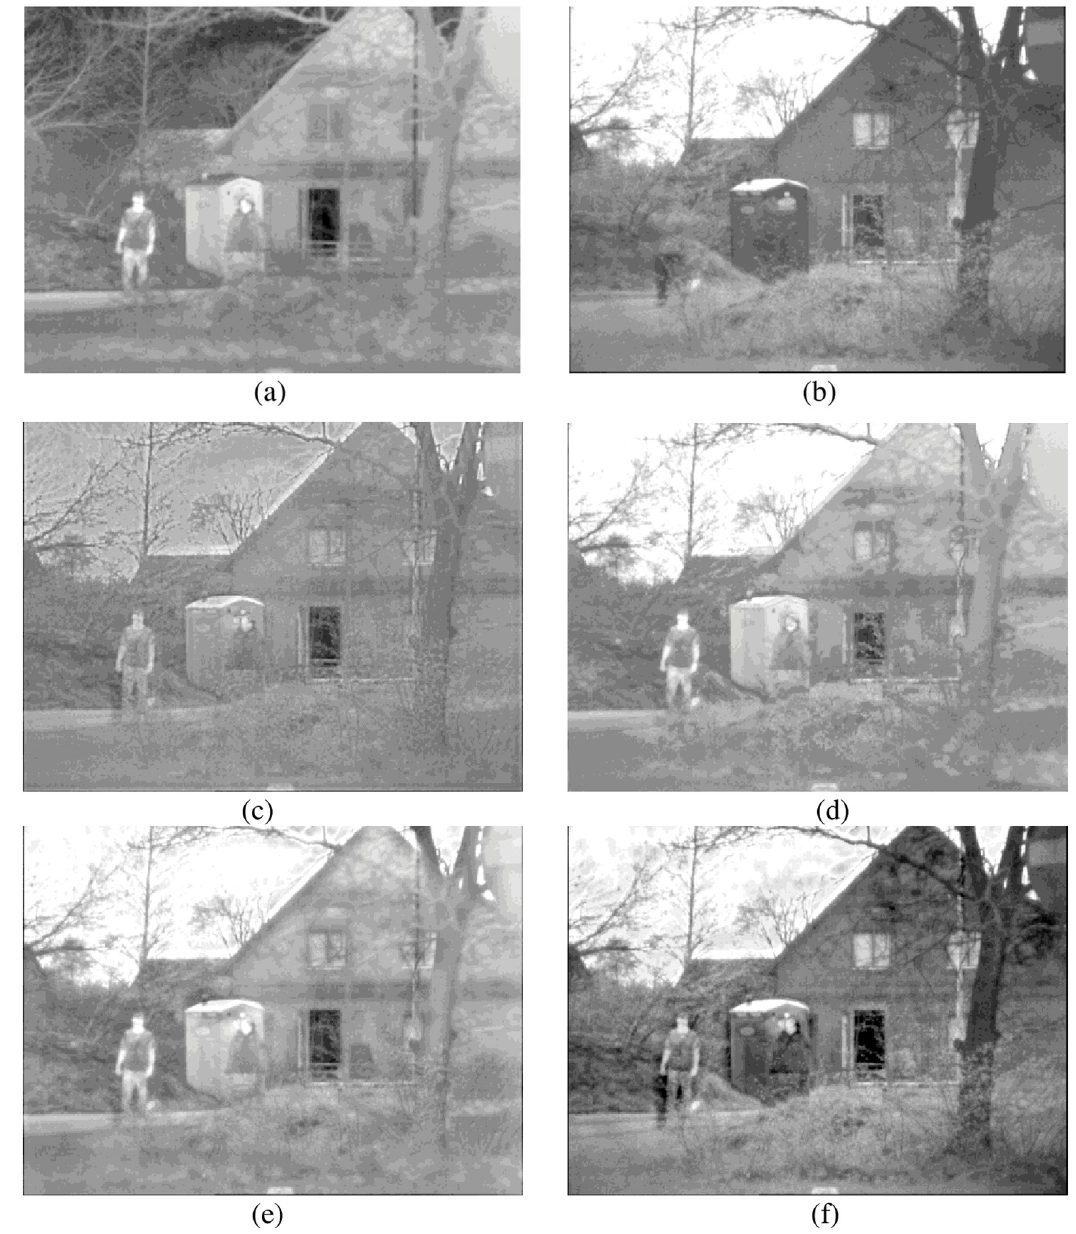
Fig 6. The first group of experimental results. (a) IR image, (b) VI image, (c) DWT, (d) PCNN, (e) NSCT_PCNN, (f) Proposed method.